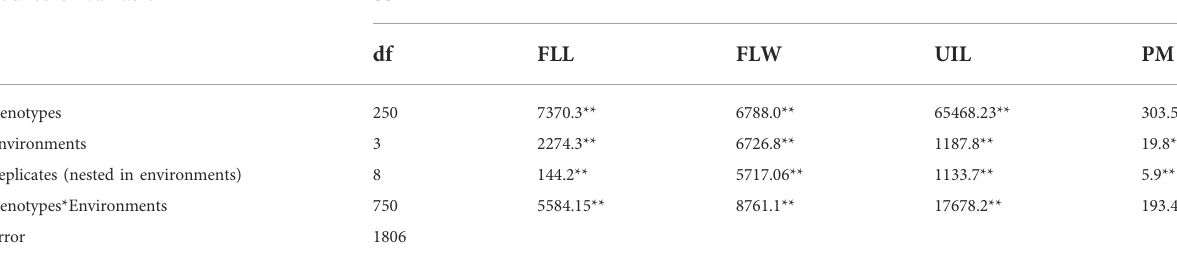
Figure S1). Among these, nine loci for FLL were identi fi ed on